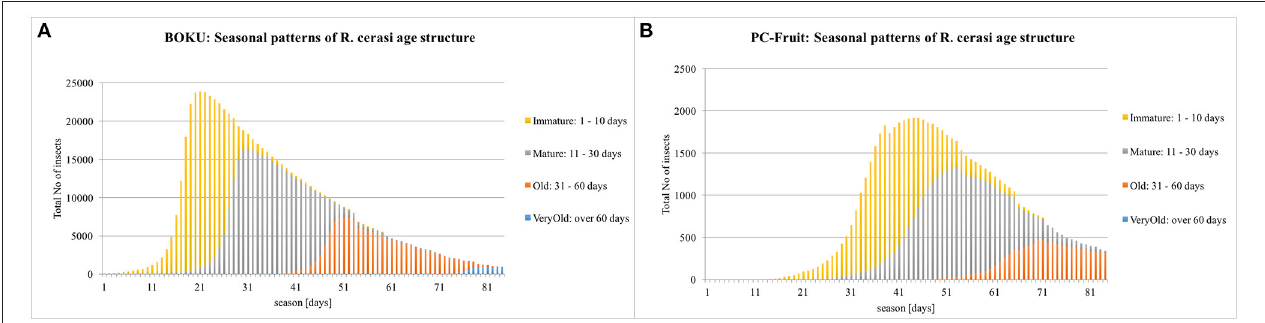
contrast to extensive overlap and largely concurrent presence in